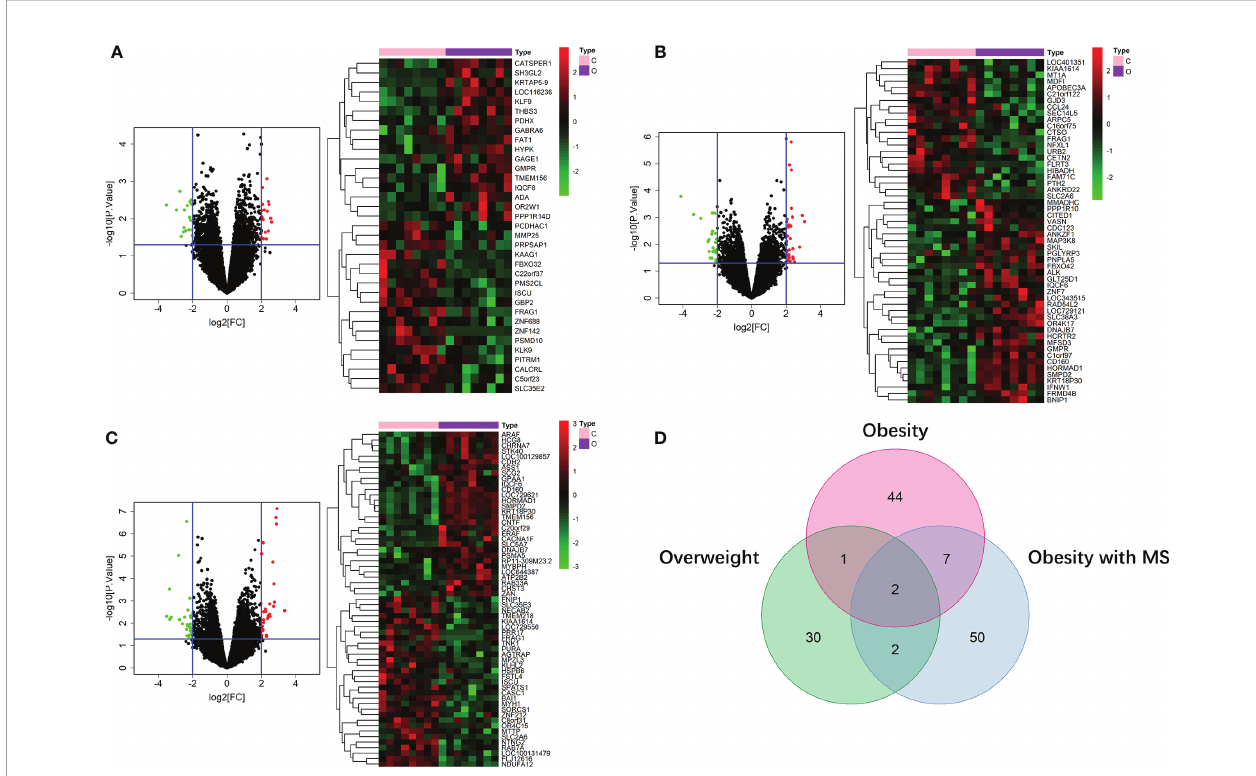
FIGURE 2 | DE mRNAs of overweight (A) , obesity (B) , and obesity with MS (C) in VAT. The red points in the volcano plots represent upregulation and the green plots represent downregulation. The color in heatmaps from green to red shows the progression from low expression to high expression. The amount of DE mRNAs of obesity in VAT was 136 (35 for overweight, 54 for obesity, and 61 for obesity with MS). Venn diagram (D) shows that only 2 mRNAs (IQCF6 and FRAG1) were shared by all these 3 obesity